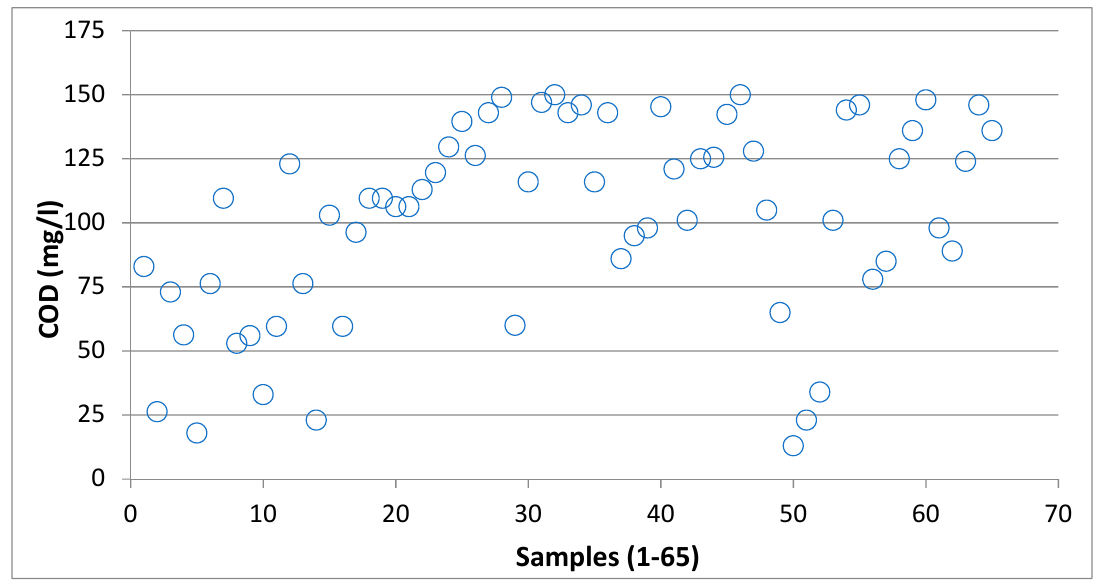
Figure 2. COD concentration in the tested condensate water samples.